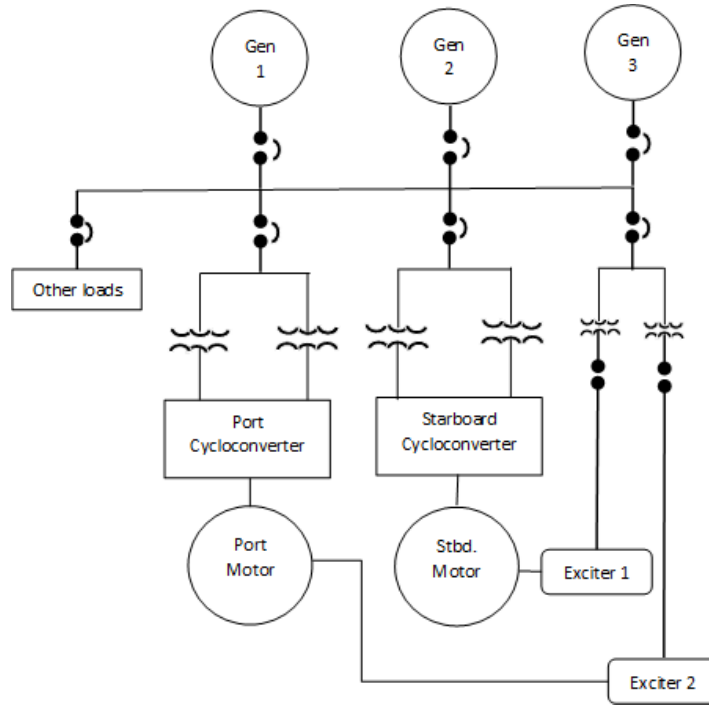
Figure 1. Typical Cycloconverter (CCV) System, [1] (p.